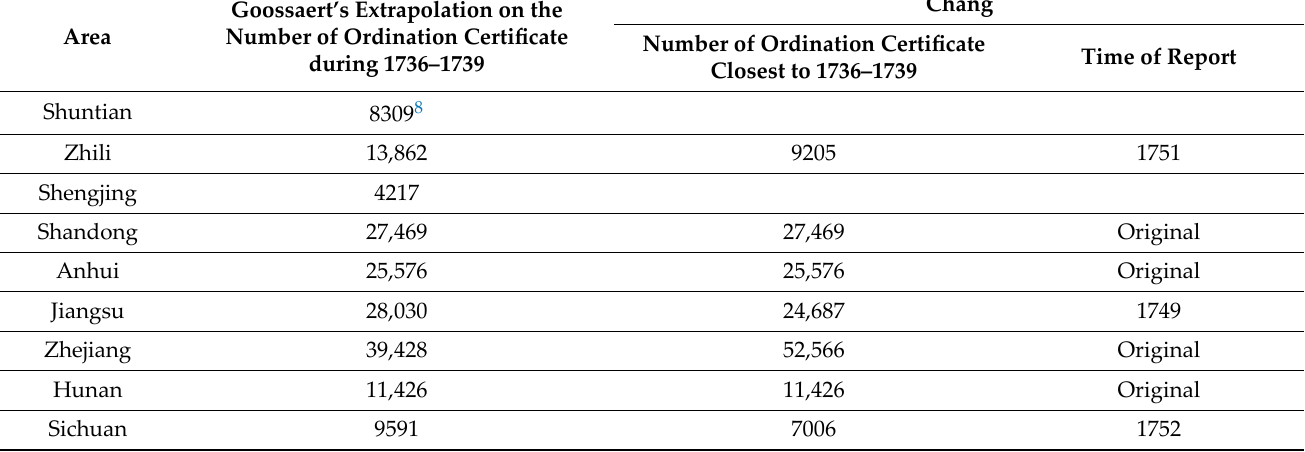
Table 3. A comparison of the similarities and differences in the estimated numbers of monks and Taoists in each province in the mid‑18th century by Professors Goossaert and